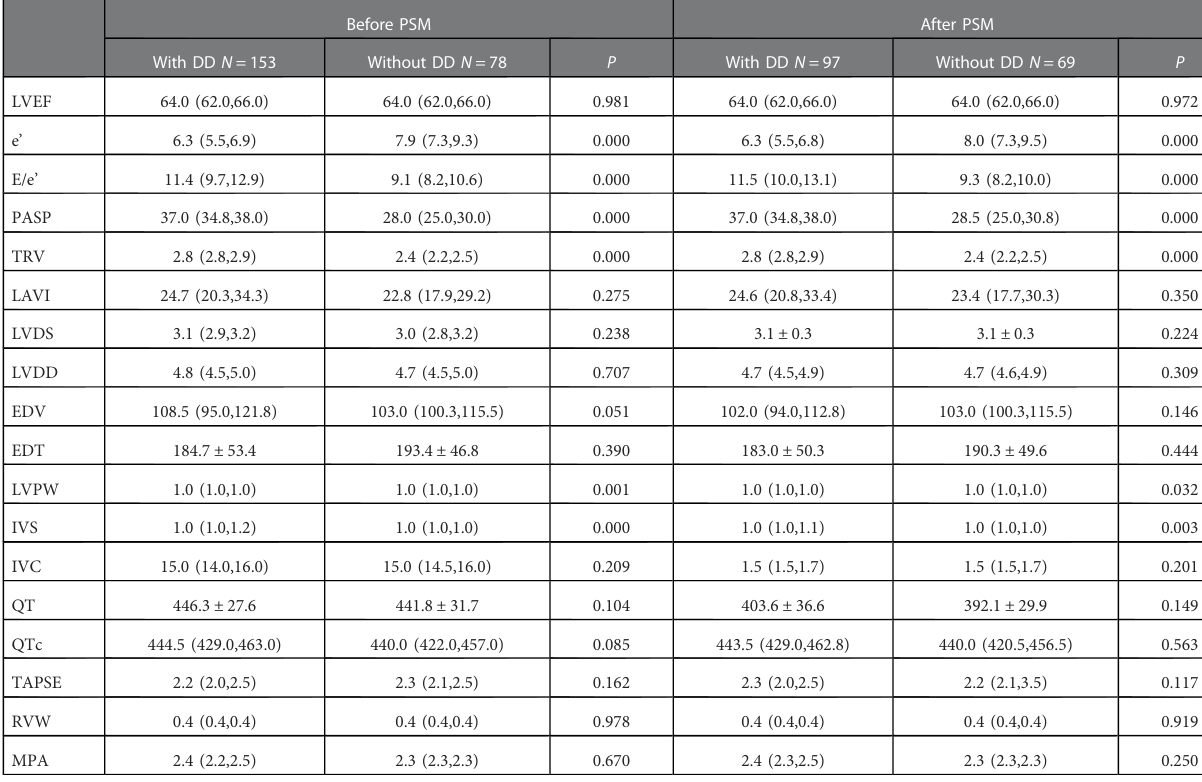
TABLE 3 Comparisons of echocardiography parameters and QT interval between patients with and without DD. Before